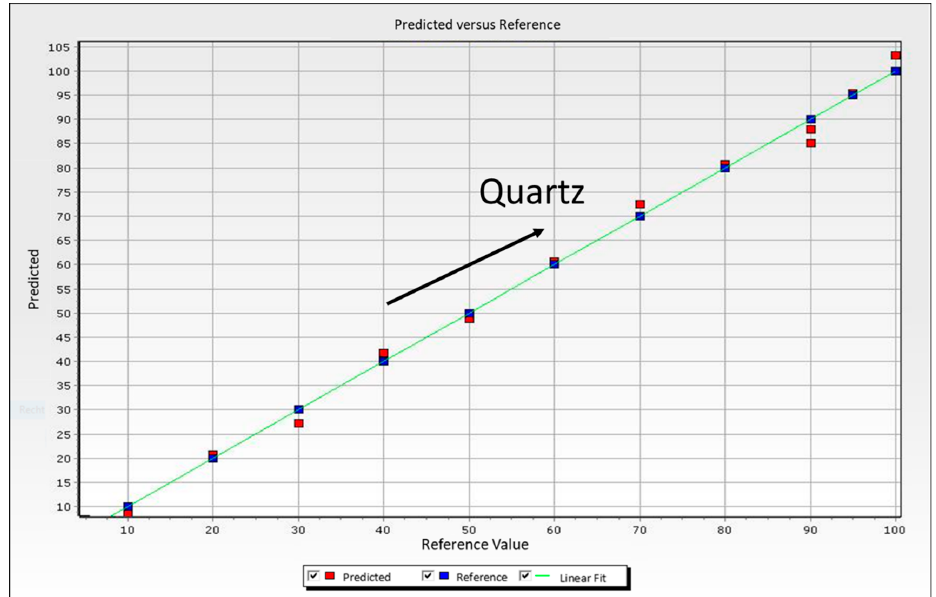
Figure 8. Calibration curve for spodumene–quartz mixtures. As an example for Rietveld refinement control of the different mixtures, the Rietveld plot for a mixture of 95% spodumene and 5% of quartz and the calculated composition is given in Figure 9.